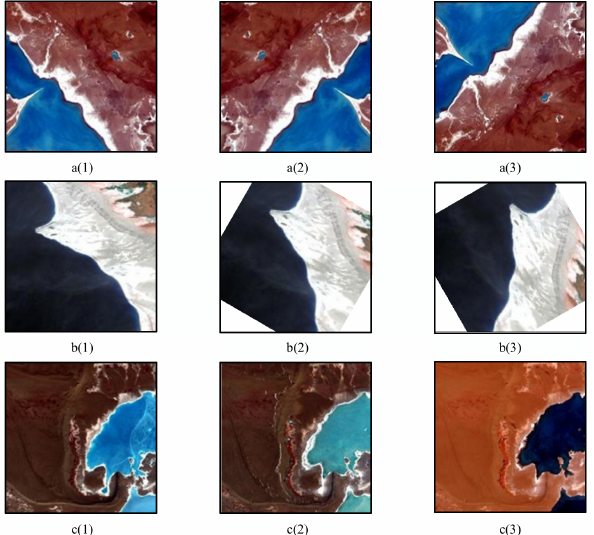
Figure 6. Data augmentation. a(1) – a(3) random flipping, b(1) – b(3) random rotation, c(1) – c(3) color enhancement. The first column indicates the original image; the second and third columns indicate the enhanced image from the first column,